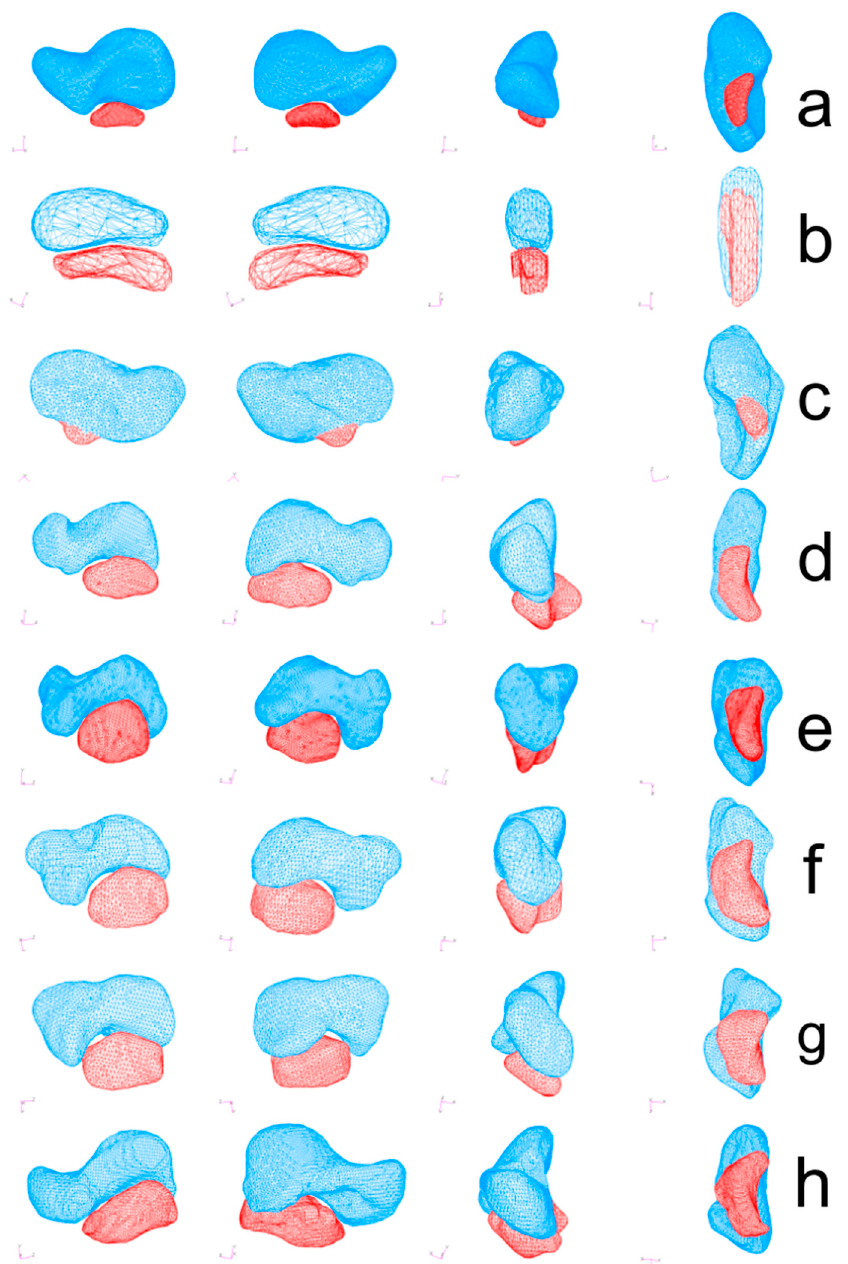
Figure 2. Polygonal models of the scaphoid (blue) and os centrale (red) were obtained using MSC Patran 2005r2 Software (MSC Software). Bipartite scaphoid in human adult ( a ), human embryo ( b ), Neanderthal (SD 258, left scaphoid) ( c ), Atele ( d ), Colobe ( e ), Macaca ( f ), Papio ( g ) and Pongo ( h ). All specimens are presented in medial view (left), lateral view (2nd column), anterior view (3rd column), and inferior view (right).